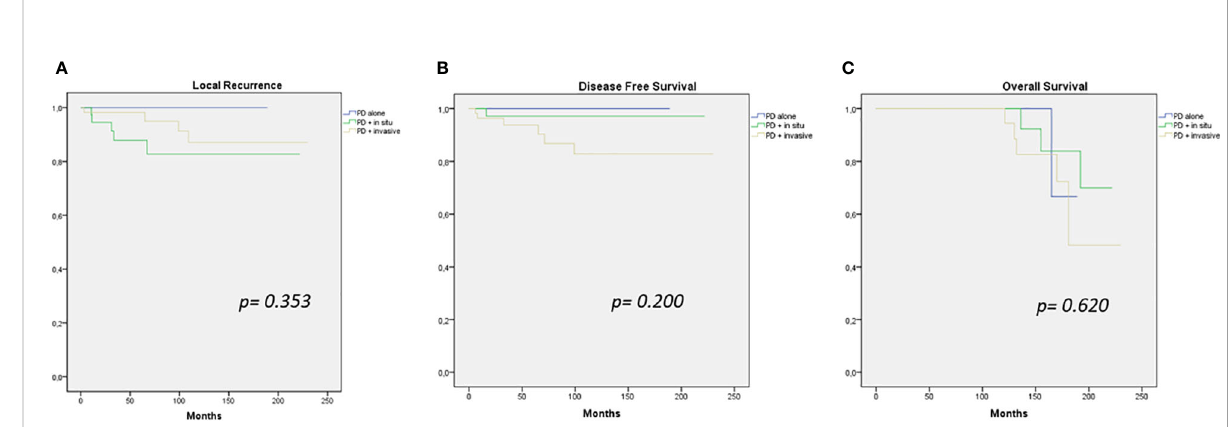
FIGURE 1 Local recurrence (A) , disease-free survival (B) , and overall survival (C) curves (PD alone – PD + in situ – PD + invasive